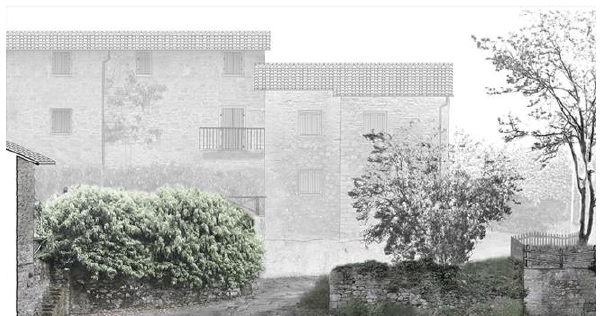
Figure 3. Survey, elevation on the road of the source before the restoration of the area.